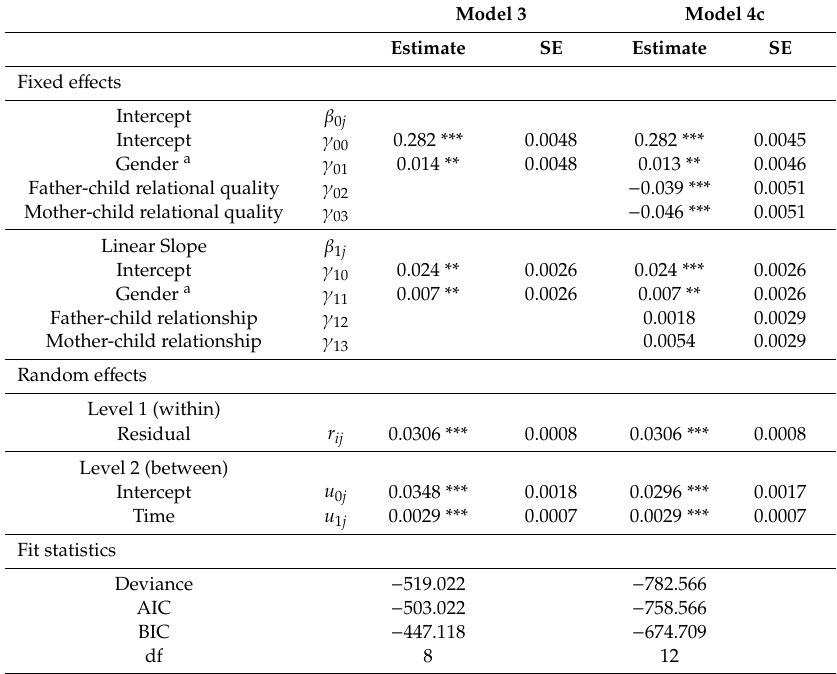
Table 7. Results of IGC models with Level-2 predictors for adolescent delinquency (Waves